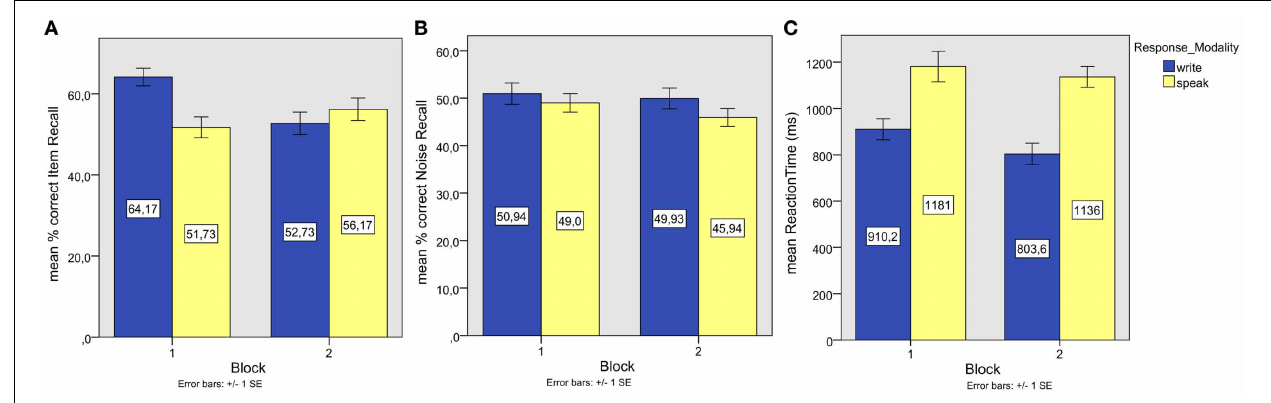
FIGURE 7 | Experiment 4. (A) Mean associate word (item) recall performance; (B) Mean episodic information (associate word presented with background noise or not) recall performance; (C) Mean reaction times of correct associate word recall responses.